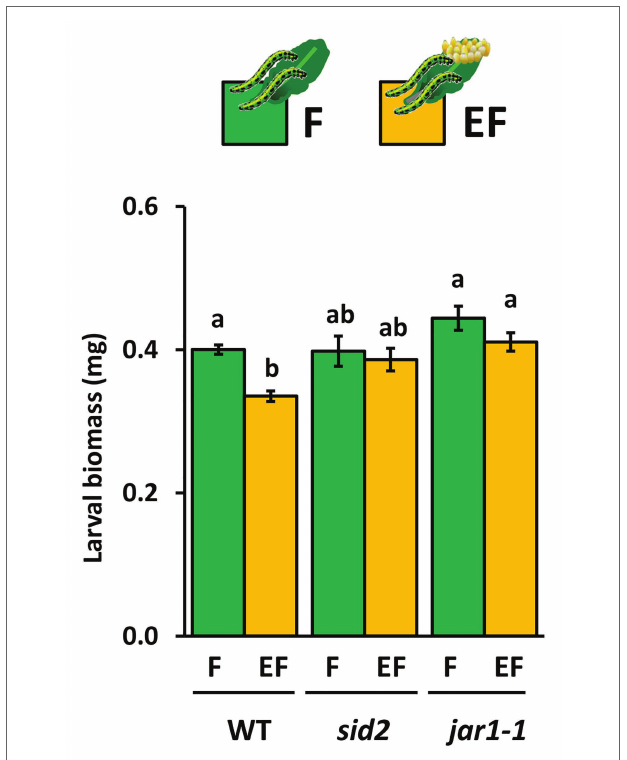
FIGURE 5 | Impact of Arabidopsis thaliana JAR1- and SID2-impairment on performance of P. brassicae larvae feeding on previously egg-laden plants. Biomass in mg (mean ± SE) of P. brassicae larvae after feeding for 48 h on egg-free (F, green) or egg-laden (EF, yellow) WT A. thaliana plants, sid2 - or jar1–1 mutant lines. Different lowercase letters above the bars indicate significant differences between the treatments at the level of p < 0.05 (ANOVA, post hoc Tukey). Biological replicates (plants) per treatment: N =